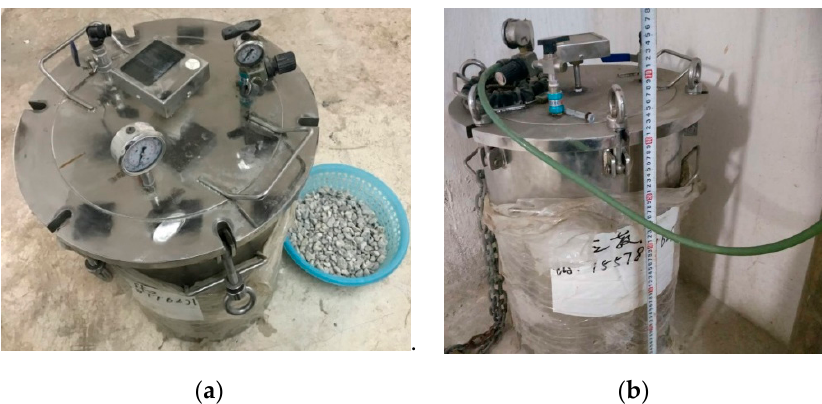
Figure 4. Experimental setup for CO 2 curing: ( a ) the upper part of the carbonized cylinder and ( b ) the side of the carbonated cylinder.